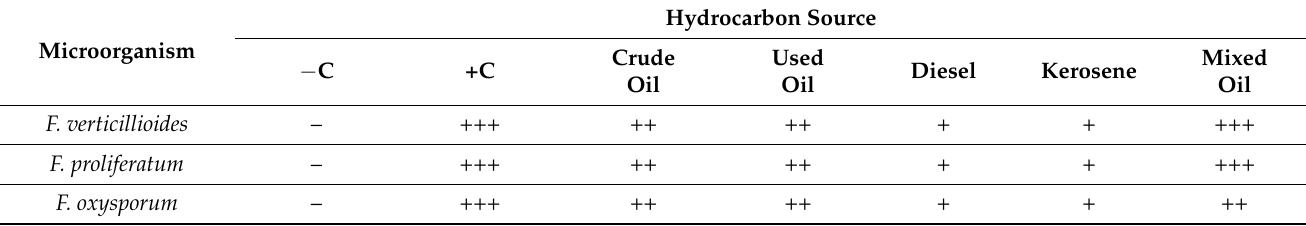
Table 4. Drop collapse test of CFSs produced by different strain of Fusarium